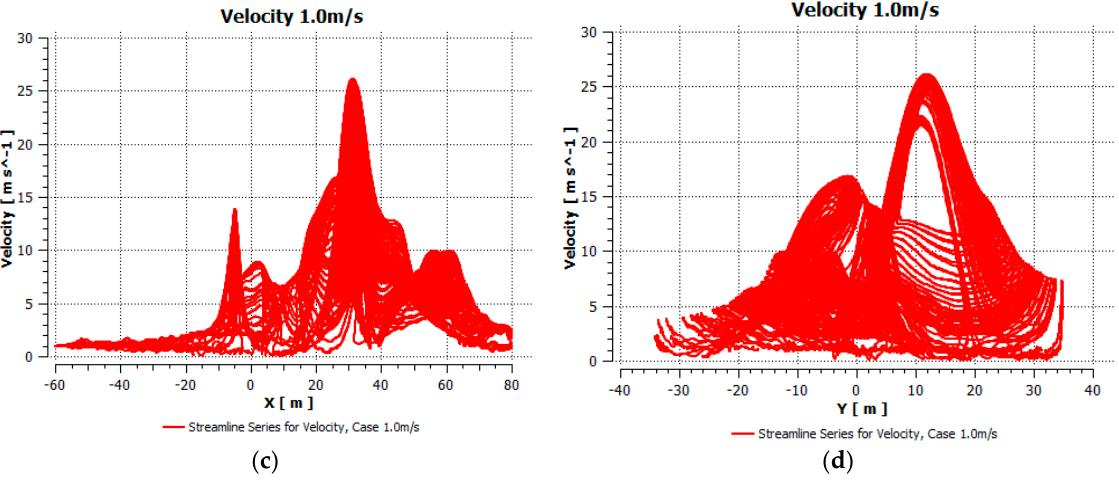
Figure 20. Velocity profile for the flow on the buoy showing the streamline series: ( a , b ) Streamline series for Velocity, case 0.45 m/s; ( c , d ) Streamline series for Velocity, case 1.0 m/s.